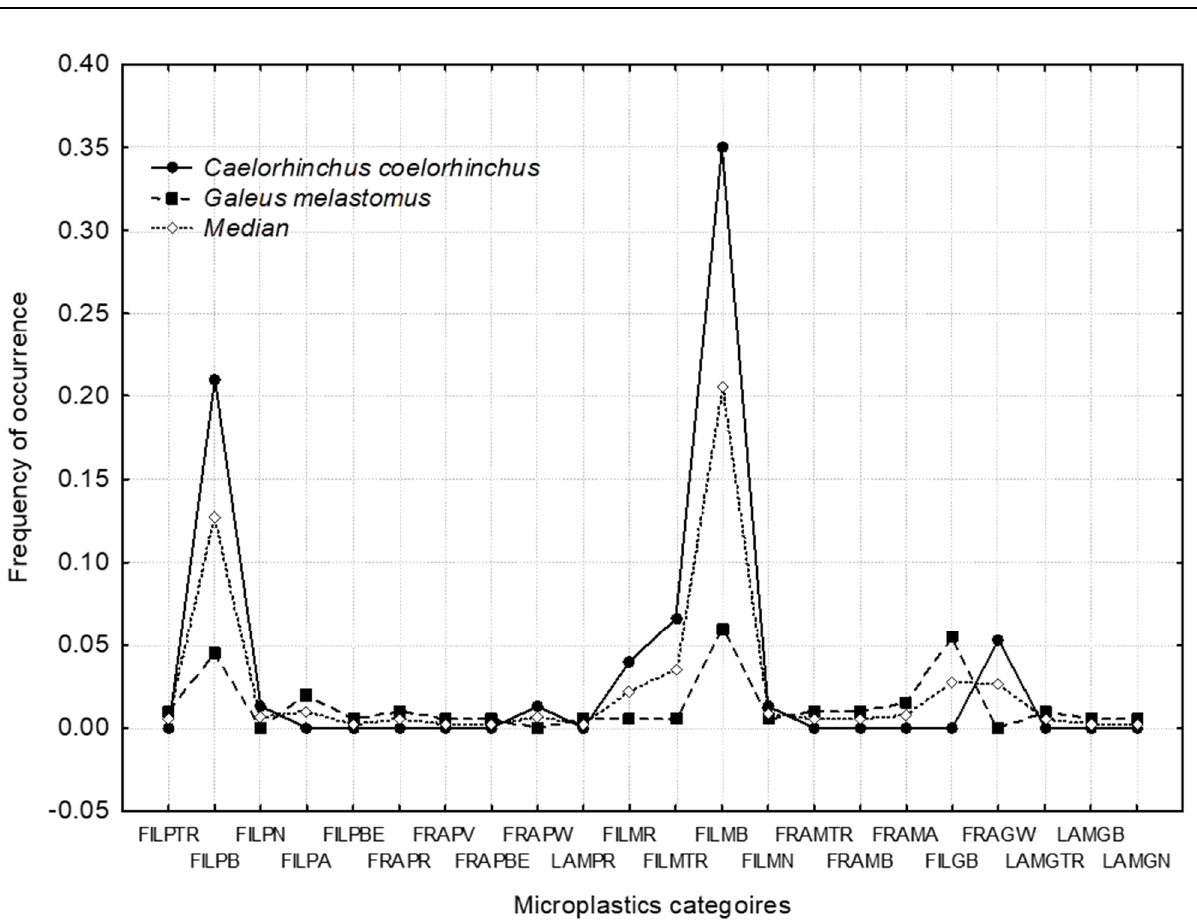
Figure 5. Comparison between values of frequency of occurrence for microplastic categories found